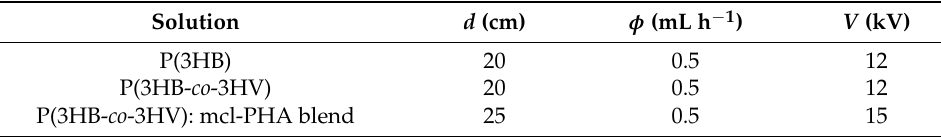
Table 2. Parameters selected to electrospin the biopolymers’